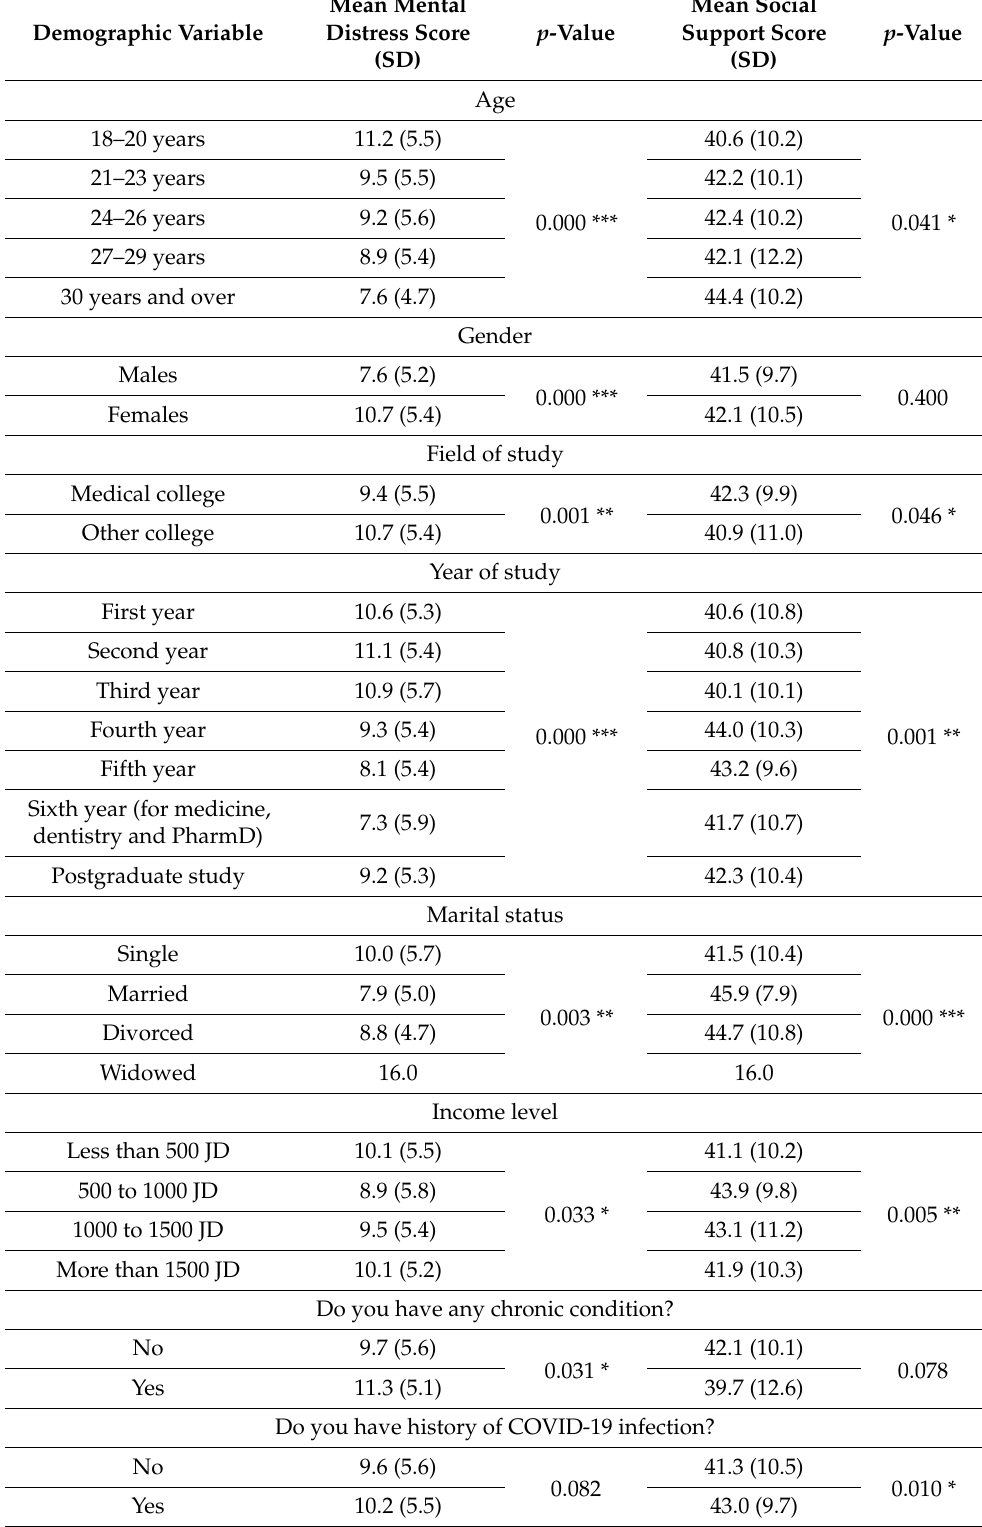
Table 3. Mean mental distress and social support score of university students stratified by demo- graphic